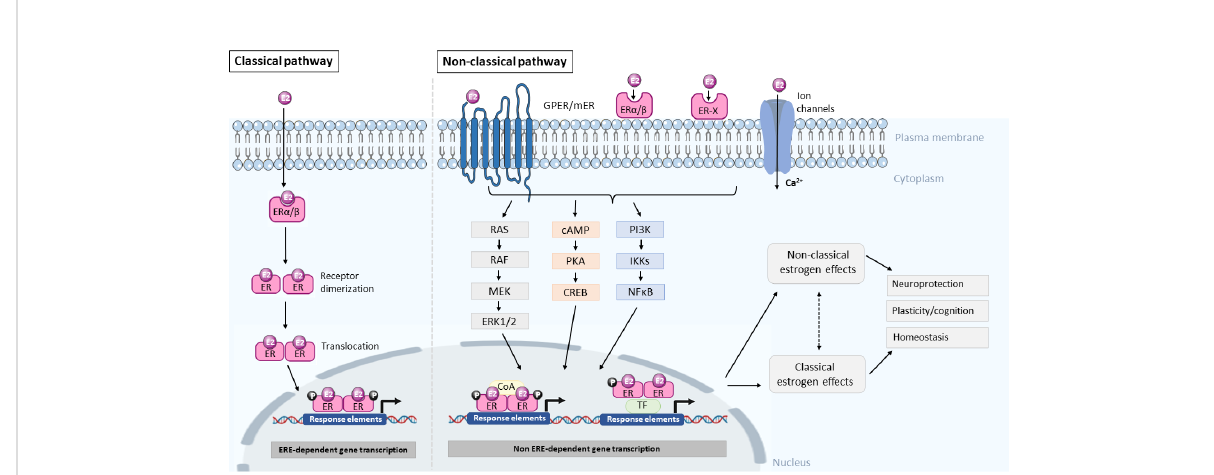
FIGURE 1 Summary diagram of the classical and non-classical modes of estrogen action. In the classical pathway, E2 crosses the plasma membrane by diffusion and binds to the estrogen receptor (ER) and forms an E2-receptor complex, which dimerizes and translocates to the nucleus to regulate gene transcription through an estrogen response element (ERE) dependent manner. In the non-classical pathway, E2 interacts with membrane bound estrogen receptors (mER), G-protein coupled estrogen receptors (GPER), ER-X, or classic ER (ER a / b ) and activates kinases and second messenger signaling pathways to phosphorylate transcription factors (TF) or coactivators to in fl uence gene transcription in the nucleus via a non-ERE-dependent manner. The resultant effect of activating these pathways is neuroprotection, modulating plasticity and cognition as well as maintenance of homeostasis. However, the extent to which the non-classical and classical pathways crosstalk or interact with each other is not known. It is likely that both pathways contribute to neuroprotection and homeostasis. RAS, Ras small GTPase, RAF, Raf kinase, MEK, mitogen-activated protein kinase, ERK1/2, extracellular signal-regulated kinase 1/2, cAMP, cyclic adenosine monophosphate, PKA, protein kinase A, CREB, cAMP-responsive element-binding protein, PI3K, phosphatidylinositol-3 kinase, IKKs, I k B kinases, NF k B, nuclear factor kappa-light-chain-enhancer of activated B cells, coA,